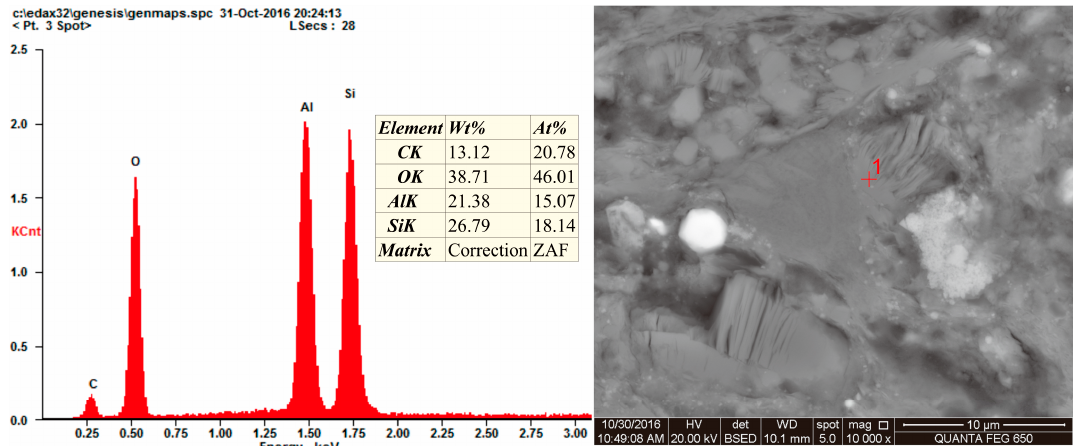
Figure 7. Scanning electron microscopy (SEM) backscattered electron image of minerals and EDS spectrum of spot 1 (SGT1-11).